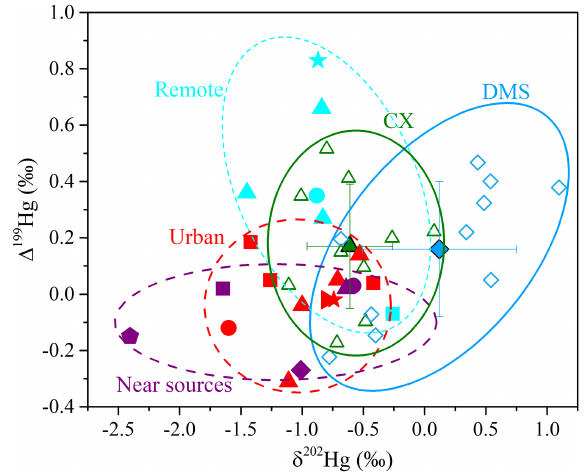
Figure 2. Isotopic compositions of Hg PM at the multiple types of sites. For this study, the green filled triangles and green empty tri- angles – mean and individual values at the CX site; the blue filled diamonds and blue empty diamonds – mean and individual values at the DMS site. For remote sites, the light blue star – coast; the light blue square and light blue triangle – mountain; the light blue circle – island (Fu et al., 2019; Rolison et al., 2013; Yu et al., 2016). For urban sites in China, the red triangle – Beijing; the red circle – Changchun; the red star – Chengdu; the red square – Guiyang; the red sideways triangle – Xi’an (Huang et al., 2015, 2016, 2019, 2020; Xu et al., 2017, 2019; Yu et al., 2016). For sites near the emis- sion sources, the purple triangle and purple square – industrial; the purple pentagon – landfill; the purple diamond – traffic; the purple circle – near the coal-fired power plant (CFPP; Das et al., 2016; Huang et al., 2018; Yu et al., 2016).